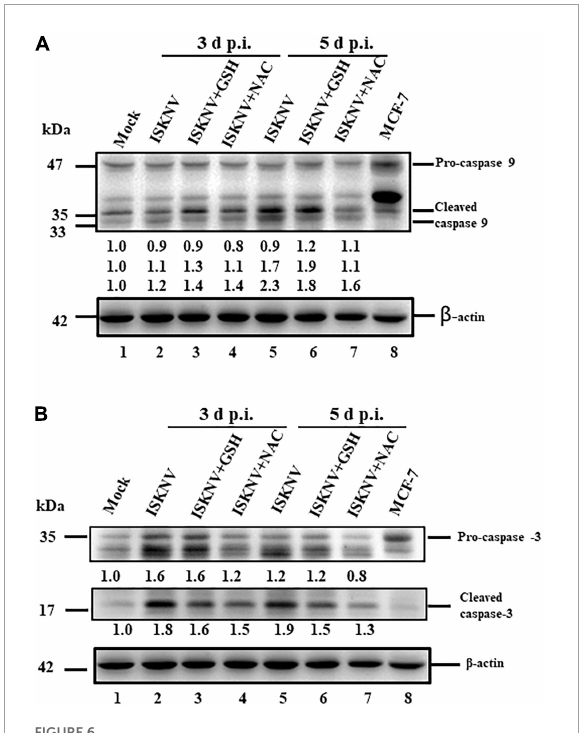
FIGURE6 Glutathione (GSH) and N -acetylcysteine (NAC) can block infectious spleen and kidney necrosis virus (ISKNV)-activated caspases-9 and -3 in fish cells. (A,B) Infection of GF-1 cells with ISKNV and either GSH and NAC treatment at day 0 (mock control), day 3, and day 5, which blocked ISKNV-induced caspase-9 (A) and caspase-3 cleavage (B) from procaspase-9 and procaspase-3, as determined by western blot analyses. Lanes 1-6 correspond to ISKNV-infected fish cells at day 0, day 3, and day 5, while lane 8 shows the control MCF-7 cell lysate. Blots were probed with anti-mouse caspase-9 and caspase-3 monoclonal antibodies (1:7,500) and an anti-mouse β -actin monoclonal antibody (1:12,500). The quantification of protein expression levels was performed using the ImageJ software, as shown in panels (A,B)